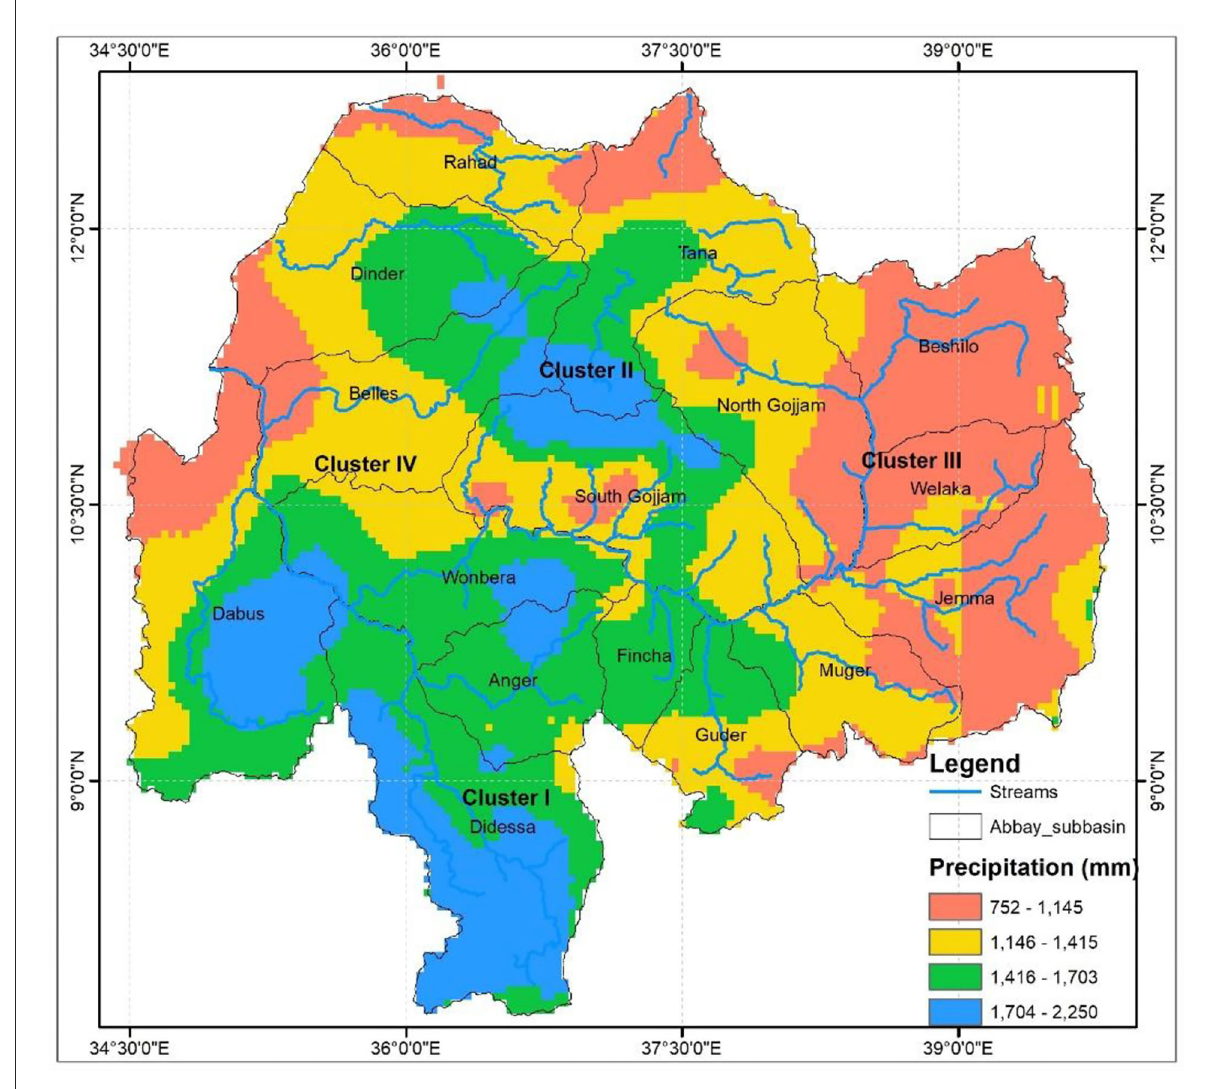
FIGURE3 Rainfall clusters in the Abbay basin (prepared based on BCEOM,